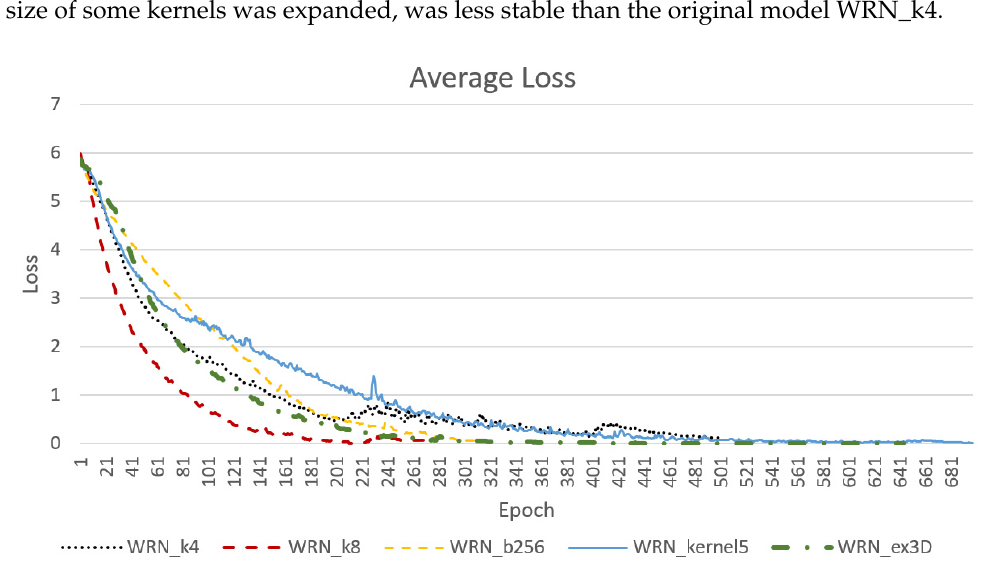
Figure 10. Convergence results of average loss under the condition where the samples were randomly distributed between training and testing sets at a 7:3 ratio.